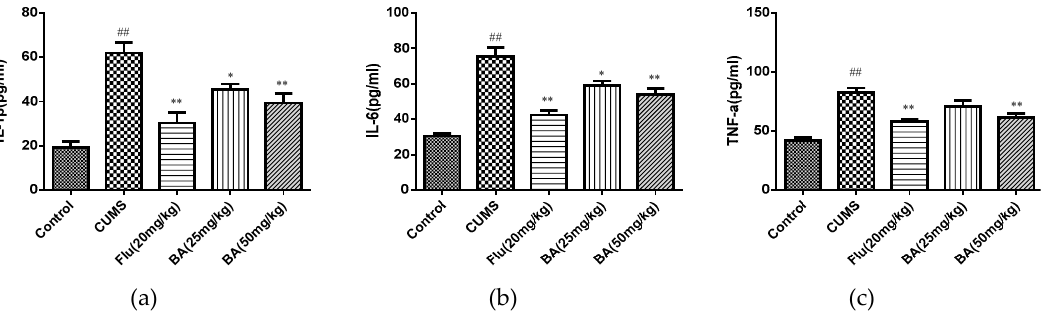
4 of 14 Figure 3. Effects of BA in the open field test (OFT). Data were expressed as mean ± SEM ( n = 12). 2.2. Effects of BA on Pro-Inflammatory Cytokines in Mice To evaluate the anti-inflammatory effects of BA, the levels of proinflammatory cytokines in the